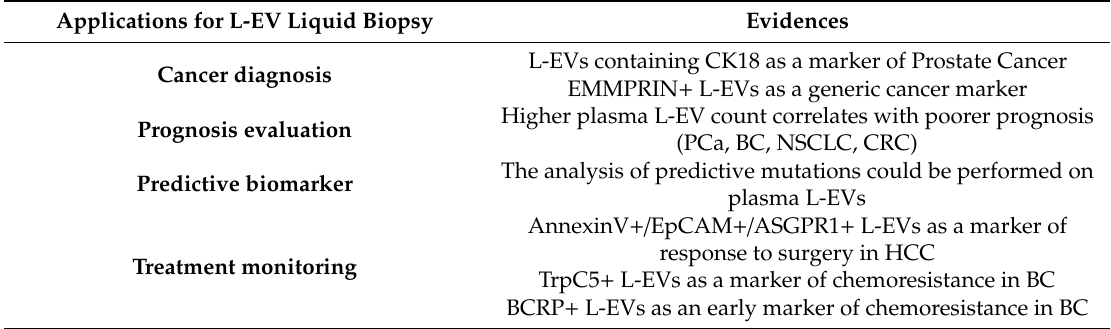
Table 2. Possible application of L-EVs liquid